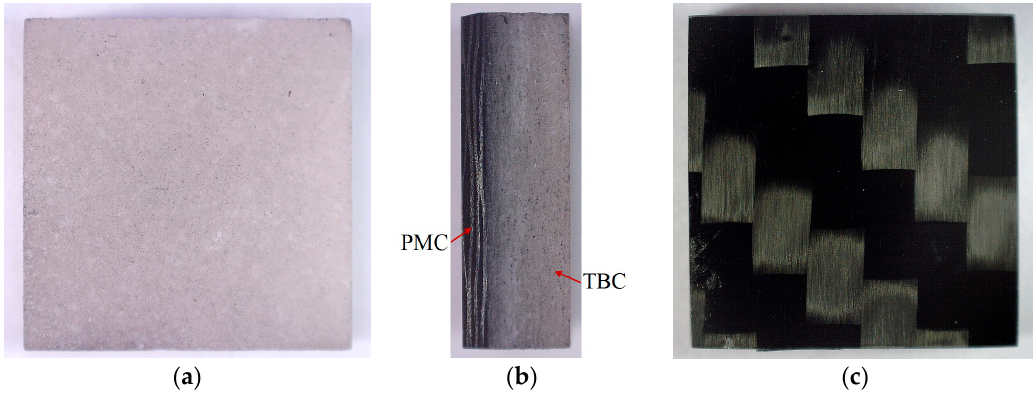
Figure 1. Polymer matrix composite (TBC) / polymer-matrix composite (PMC) sample: ( a ) the TBC ceramic mat protective layer, ( b ) cross section of the TBC / PMC system, and ( c ) the PMC